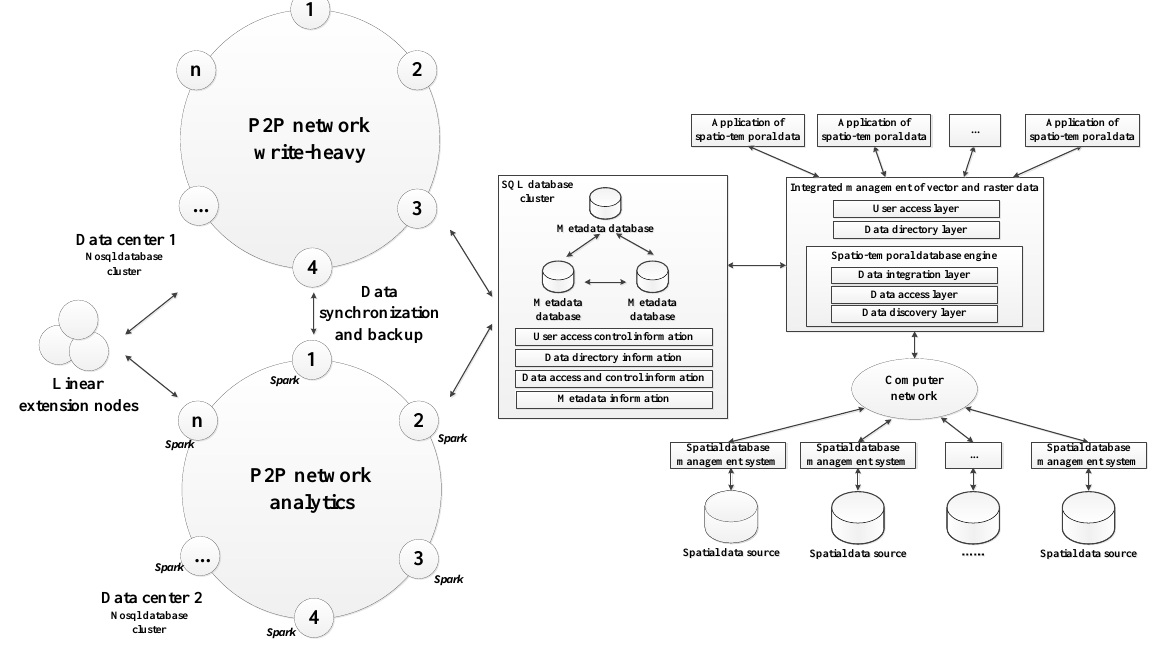
Figure 1. P2P-based distribute integrated storage model for vector data and raster data Data discovery layer mainly solves the problem of